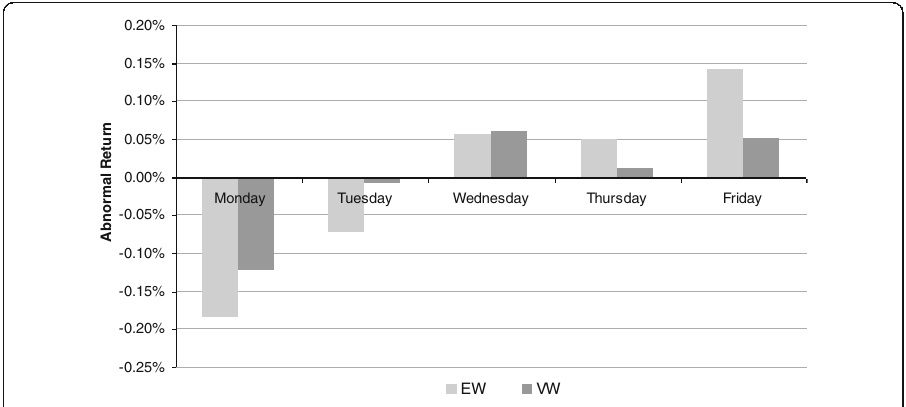
Fig. 1 Day-of-the-week effect for the EW and VW portfolios 1953 –